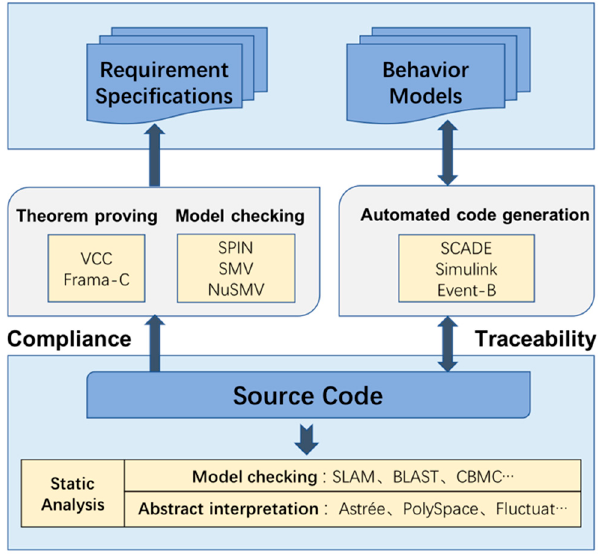
Figure 3. Formal methods of design layer and source code.